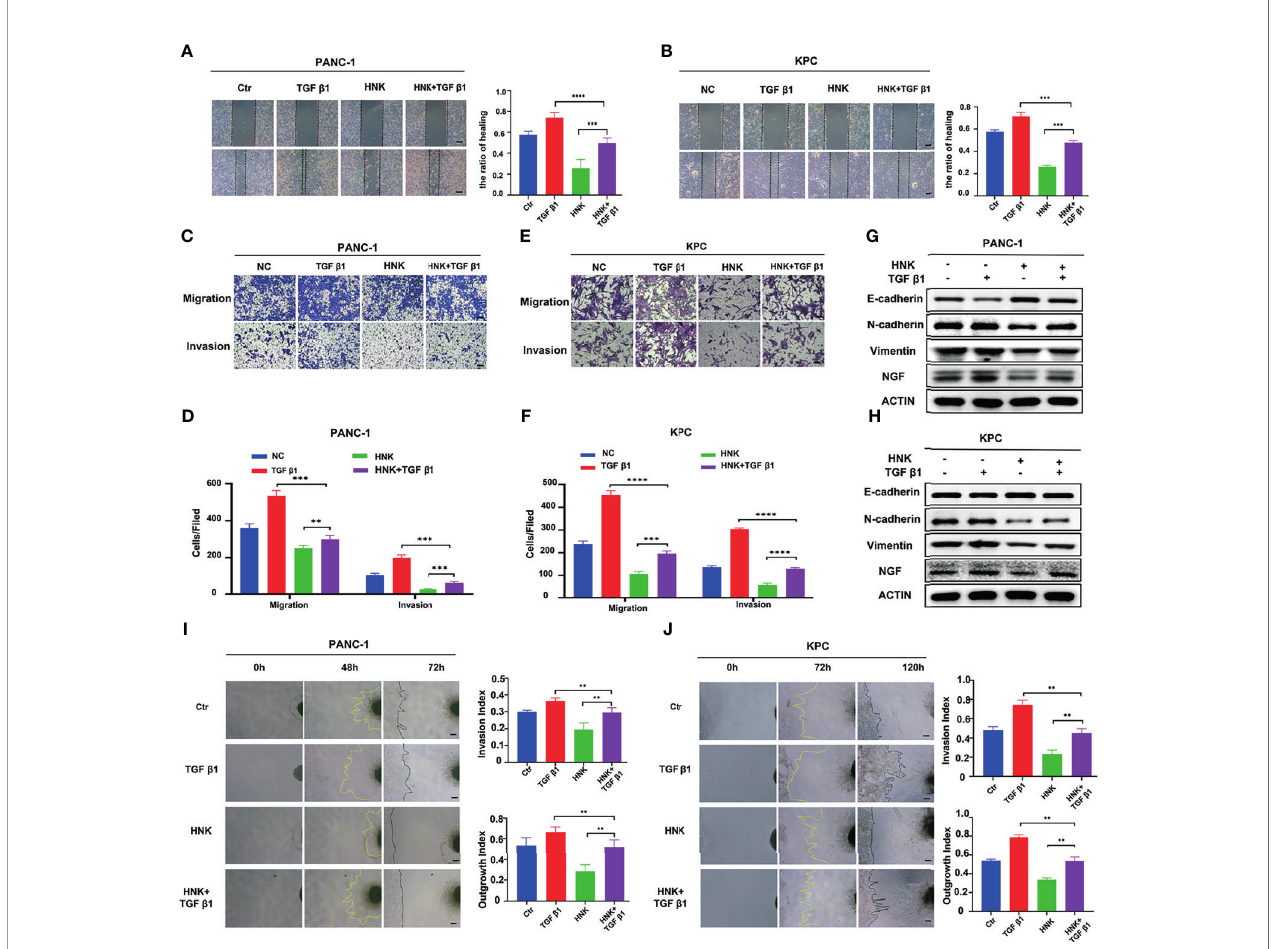
FIGURE 5 | HNK suppresses perineural invasion by inhibiting SMAD2/3 signaling. (A, B) Wound healing assays of the control group, HNK group, TGF b 1 group, and HNK+TGF b 1 group, scale bar = 200 m m; (C – F) Migration assay and invasion assay of the control group, HNK group, TGF b 1 group, and HNK+TGF b 1 group, scale bar = 100 m m; (G, H) Western blotting analysis of the expression of NGF, N-cadherin, E-cadherin, and Vimentin. (I, J) Cancer cell-DRG coculture model of the control group, HNK group, TGF b 1 group, and HNK+TGF b 1 group, scale bar = 200 m m; ** p < 0.01, *** p < 0.001, **** p <